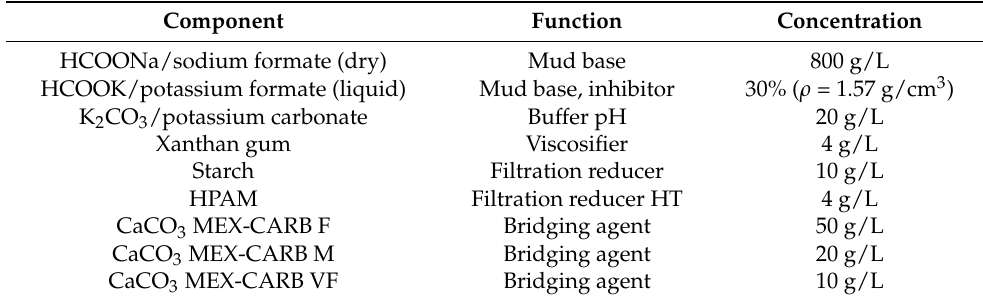
Table 2. Composition of the formate-based solution. Component Function Concentration HCOONa/sodium formate (dry) Mud